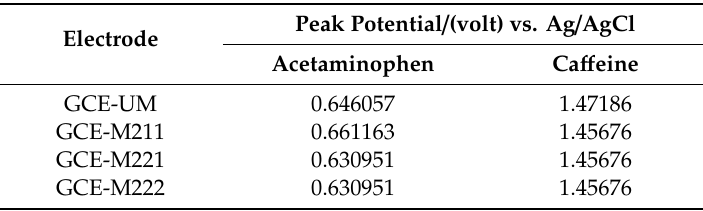
Table 2. Peak potential for oxidation of acetaminophen and ca ff eine using working